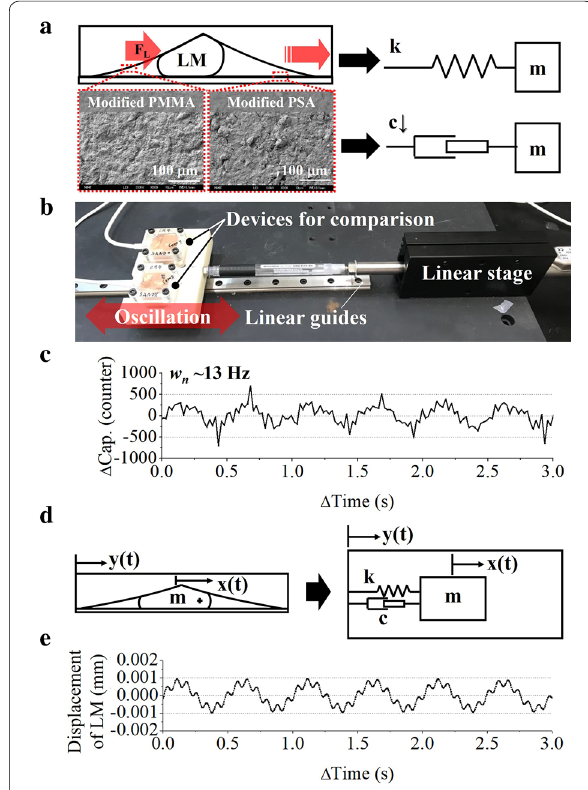
Fig. 2 a Consideration of the Laplace pressure and sandblasting treatment as a spring and for reducing the damping effect, respectively. b Setup for oscillating the device. c Experimental result: 13 Hz of natural vibration frequency with a sandblasting‑treated device (with a small damping) (8 μL of LM, oscillation frequency: 2 Hz). d Application of the device to the base excitation model. e Mathematical result from the base excitation